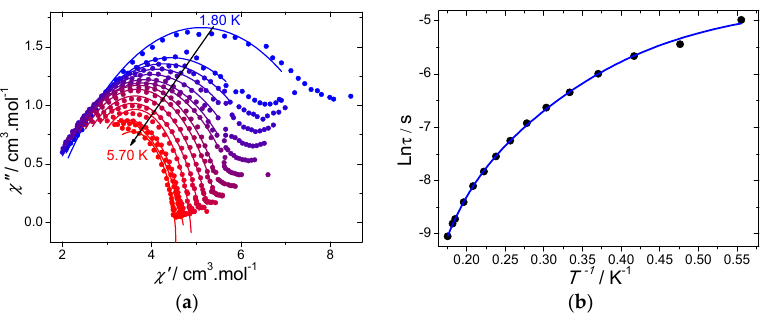
Figure 4. ( a ) Cole–Cole plots using the ac data performed under a 2250 Oe DC field for 1 . The solid lines correspond to the fit with a generalized Debye model; ( b ) Temperature dependence of the relaxation time using the ac data under a 2250 Oe DC field. The blue solid line corresponds to the fit with Equation (2). The best fit parameters gave: ∆ = 10 ± 1 cm − 1 , τ 0 = (2.7 ± 0.6) × 10 − 6 s, C = 0.0078 ± 0.0003 s − 1 · K − 9 and A = 79 ± 15 s − 1 · K − 1 . The small value of ∆ suggests a moderate contribution